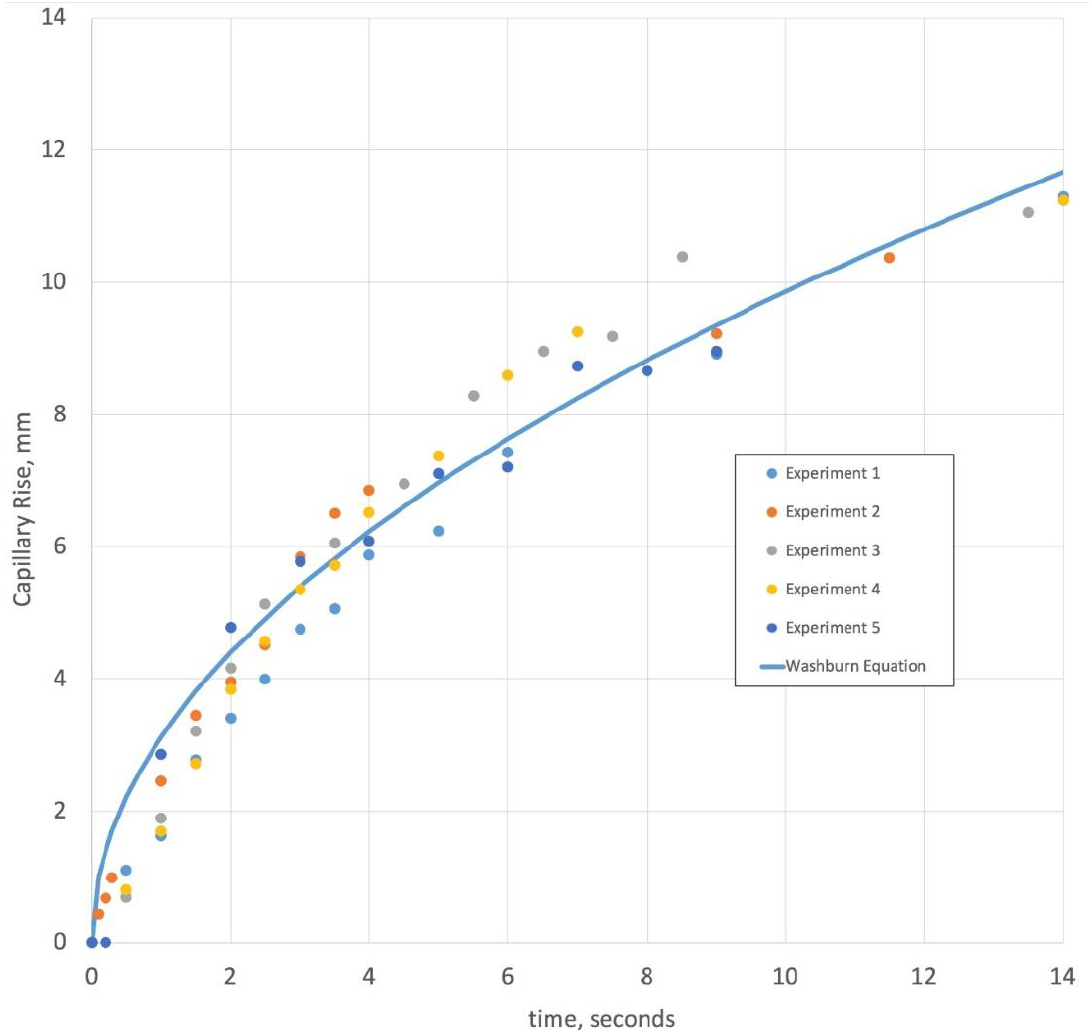
Figure 2. This figure shows the results of 5 capillary rise visualization experiments using 50% glycerol in water at 24 °C. The blue solid line is the best fit for the Washburn equation through the data points. The correlation coefficient is 0.98 for the 62 data points represented by filled circles of yellow, dark blue, light blue, orange, and grey.